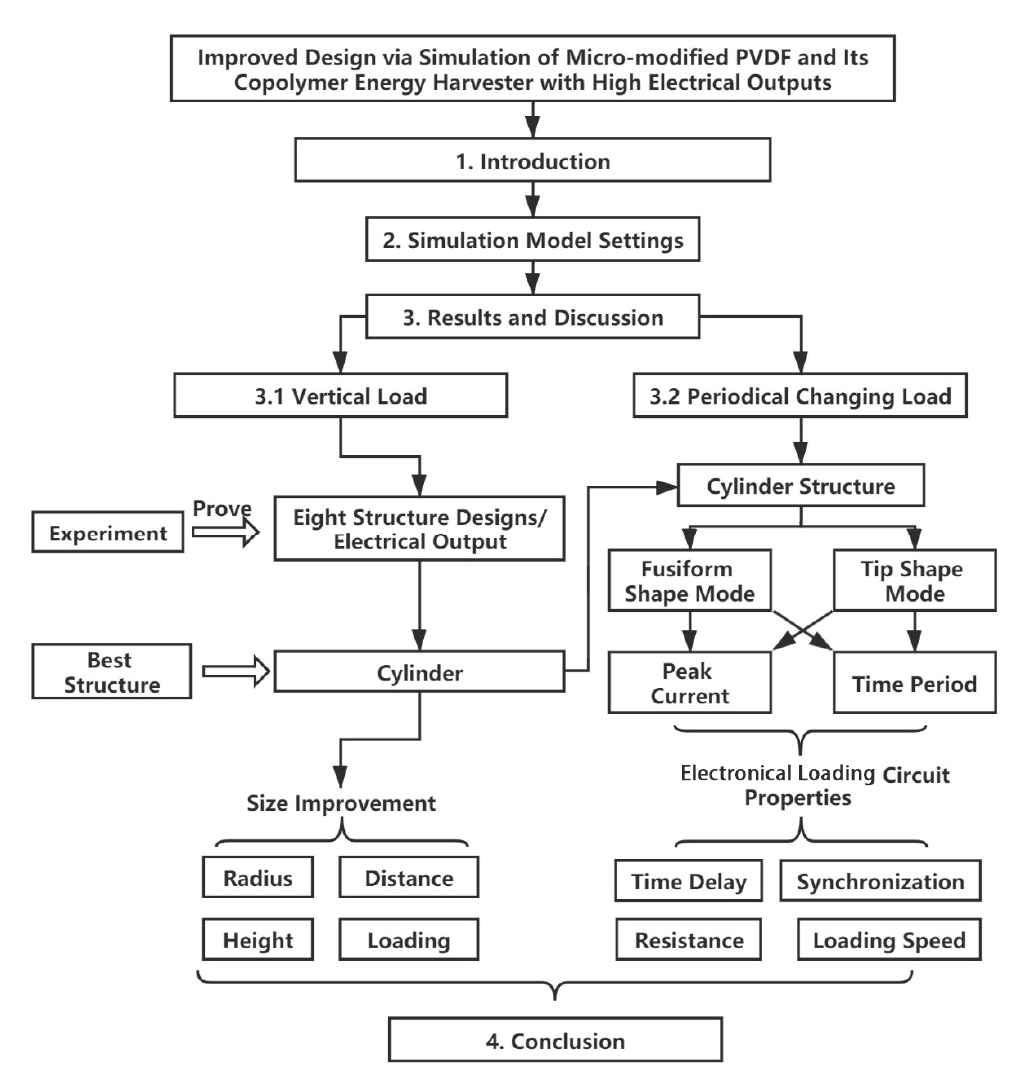
Figure 1. Main structure of the paper.